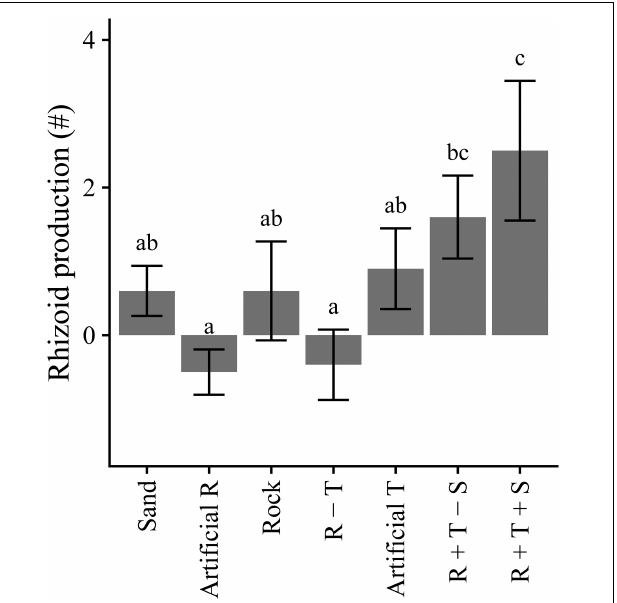
FIGURE 7 | Production of rhizoid clusters ( ± SE) over 10-day experimental period across substrata, averaged over levels of Propagule quality ( n = 10). Different letters indicate significant differences between levels of Substrate ( p < 0.05). R, rock; T, turf; S,